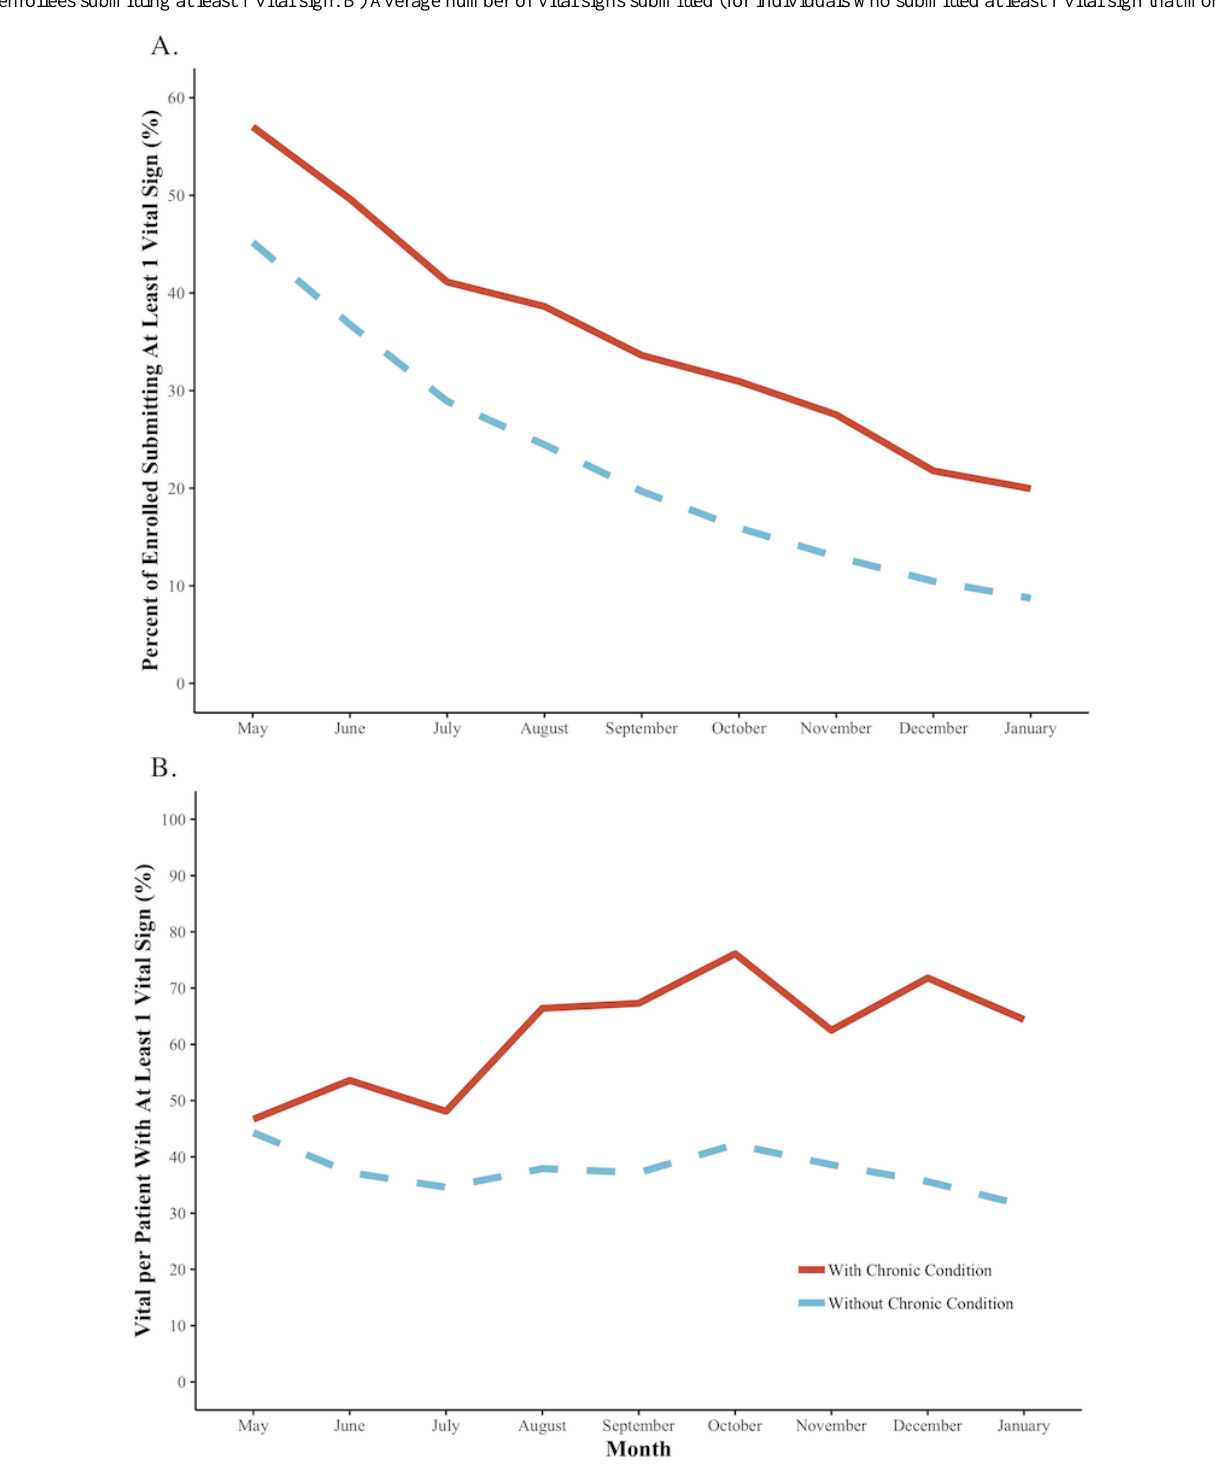
Figure 3. Submissions by without chronic condition (dotted lines) and chronic condition (solid lines) cohorts for each month of the pilot. A) Percentage of enrollees submitting at least 1 vital sign. B) Average number of vital signs submitted (for individuals who submitted at least 1 vital sign that